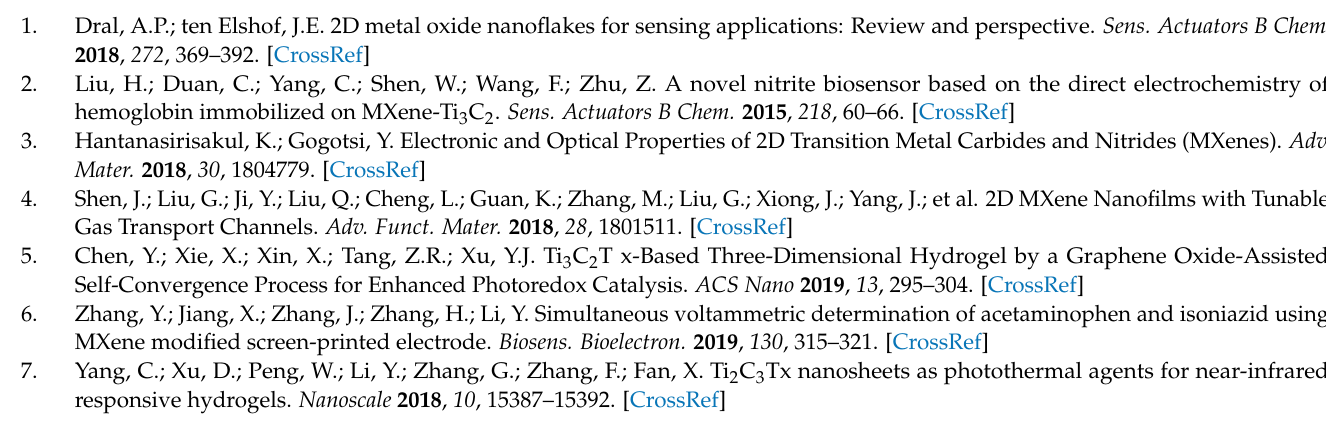
Figure S2: FESEM images of PPy with different concentration of MO, Figure S3: XPS spectra and UV-vis spectra, Figure S4: CV behaviors of bare, PPy and MXene/PPy modified electrode, Figure S5: Anti-interference and stability of MXene/PPy modified electrode, Table S1: Comparison of the electrochemical effective surface area of PPy modified and MXene/PPy modified